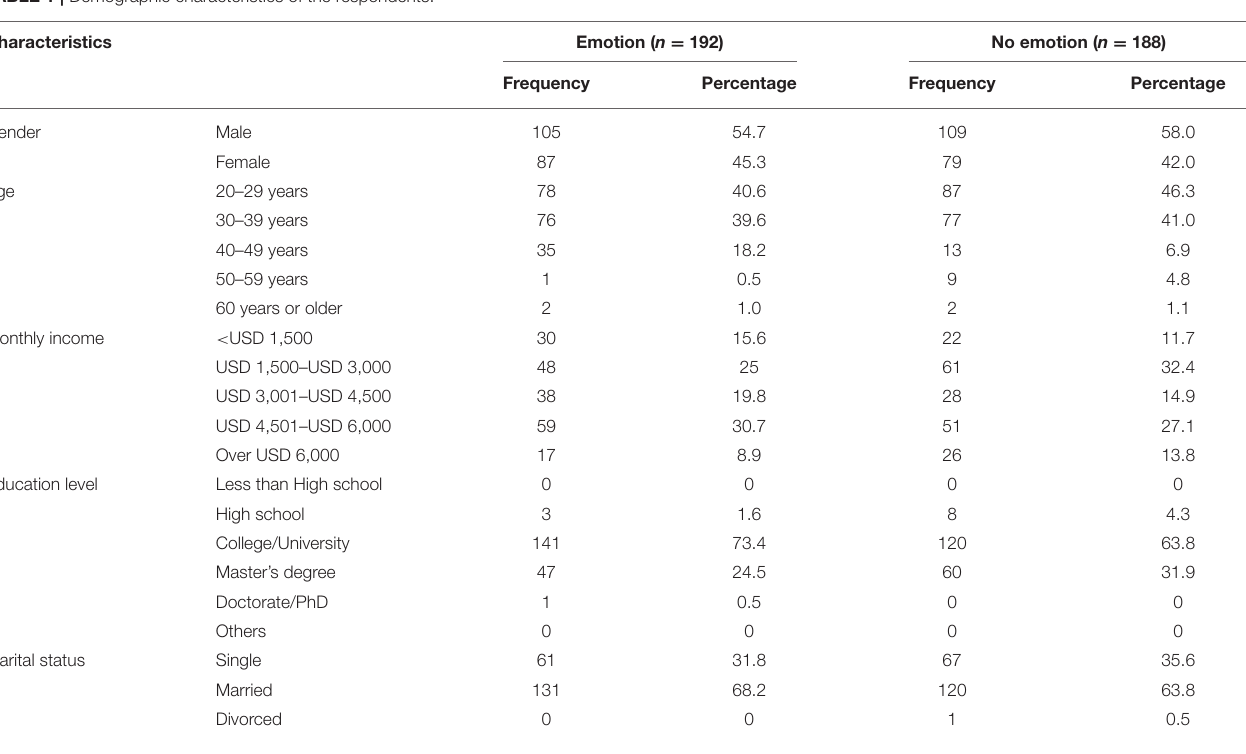
TABLE 1 | Demographic characteristics of the